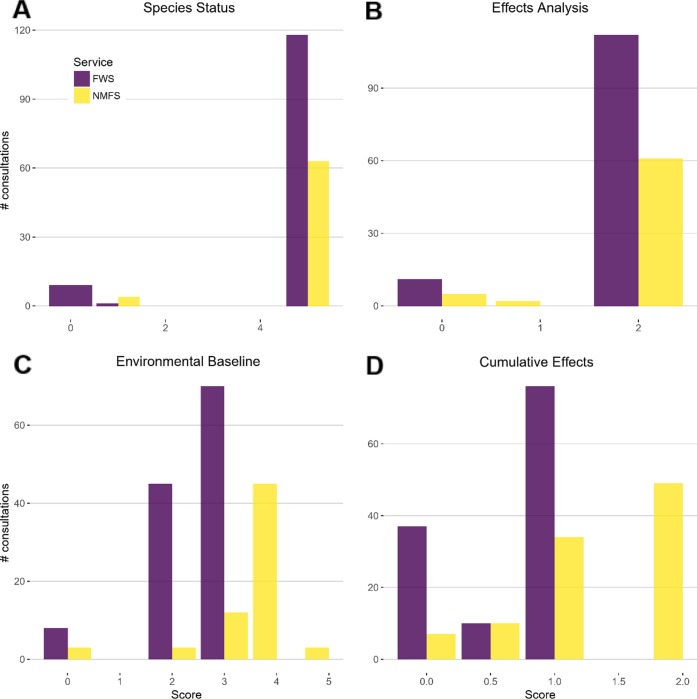
Individual components of consultations produced by NMFS showed higher completeness scores than those by FWS on average.However, the only component that statistically differed between the Services was the Environmental Baseline (z = 5.3993, p = 6.691e-08; ORNMFS = 2.6e4 [95% CI = 6.5e2–1.1e6]). The scores are the raw completeness scores for formal consultation components.